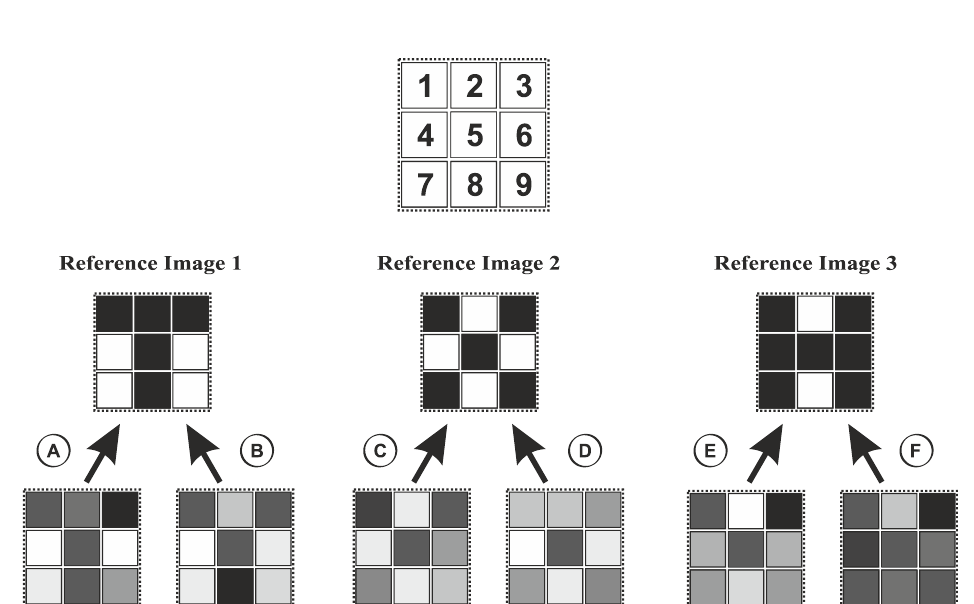
Figure 11. The numbering of neurons in the networks (IHN1 and IHN2), reference images (“T”, “X” and “H”) and input patterns (A–F) with gray gradation as in Figure 8. (A) and (B) are recognized as Reference Image 1, (C) and (D) are recognized as Reference Image 2, (E) and (F) are recognized as Reference Image 3.